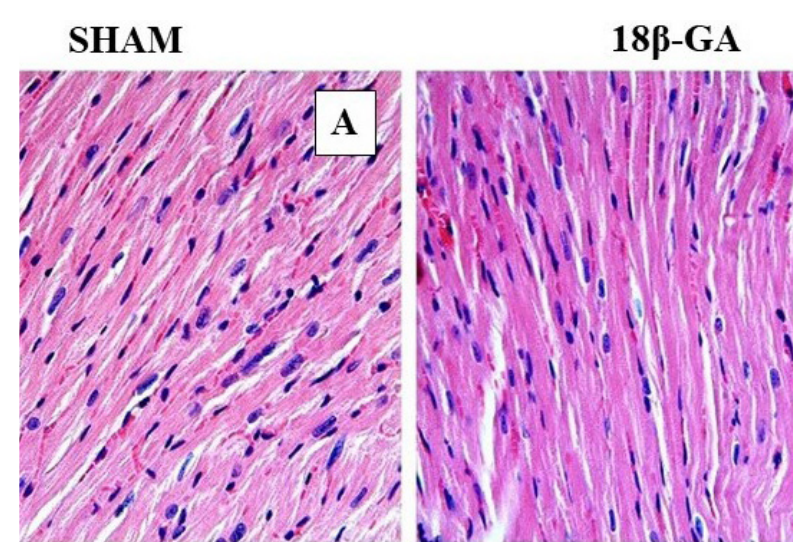
FIGURE 1 - Histological appearance of the heart tissues in the sham and 18 β -GA groups (A):H-E; X40, (B): H-E;